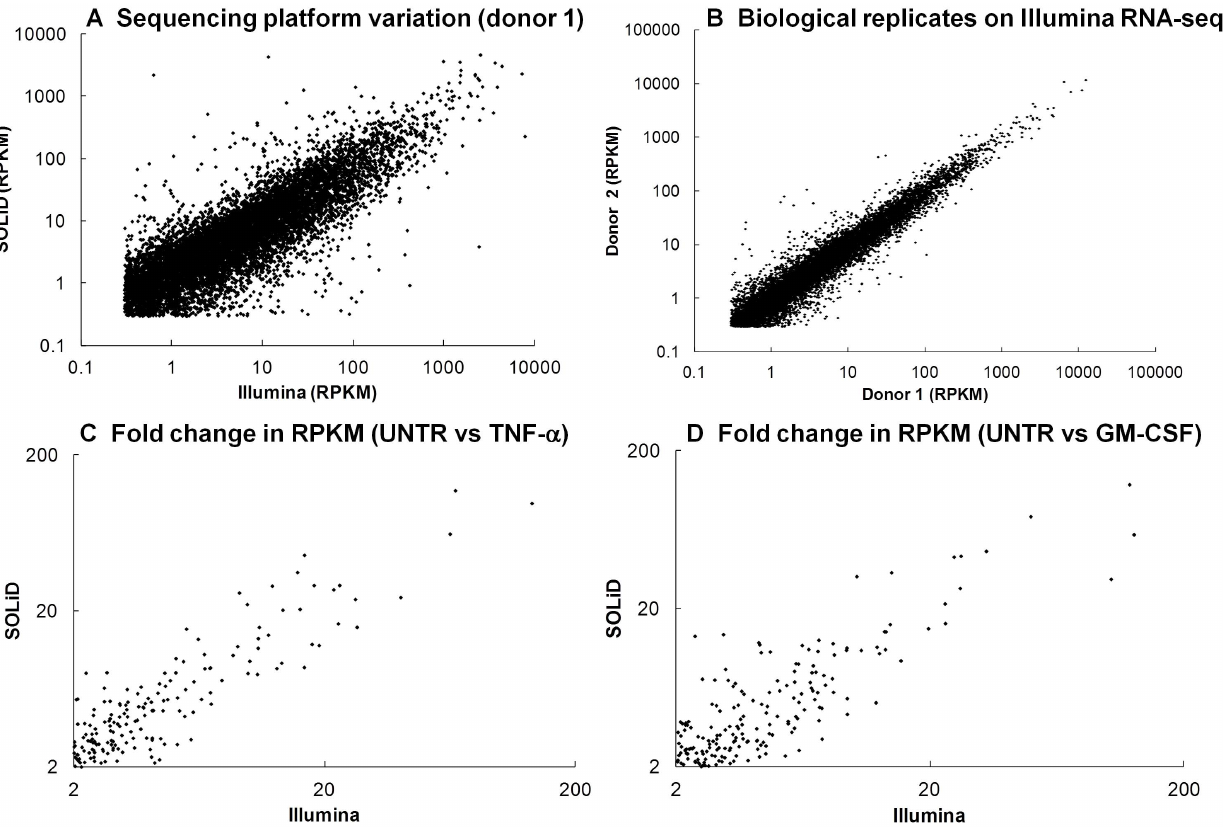
Figure 2. Comparison of sequencing platform variation and biological variation. (A) RPKM values ( $ 0.3) for untreated neutrophils from the same donor sequenced on the SOLiD v4.0 and Illumina HiSeq 2000 platforms (Rs=0.784, Pearson Correlation). (B) RPKM values ( $ 0.3) for untreated neutrophils from two different biological donors sequenced on the Illumina HiSeq 2000 platform (Rs=0.947, Pearson Correlation). (C,D) Correlation between the fold change in RPKM value for genes up-regulated by (C) TNF- a (Rs=0.885) and (D) GM-CSF (Rs=0.831) measured in neutrophils from the same donor on the SOLiD v4.0 and Illumina HiSeq 2000 platforms.